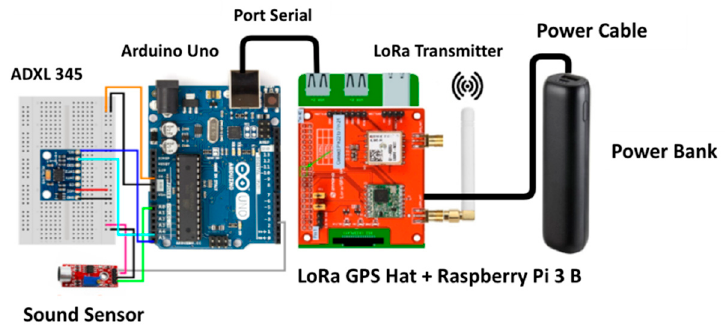
Figure 3. Sensor Node Architecture.